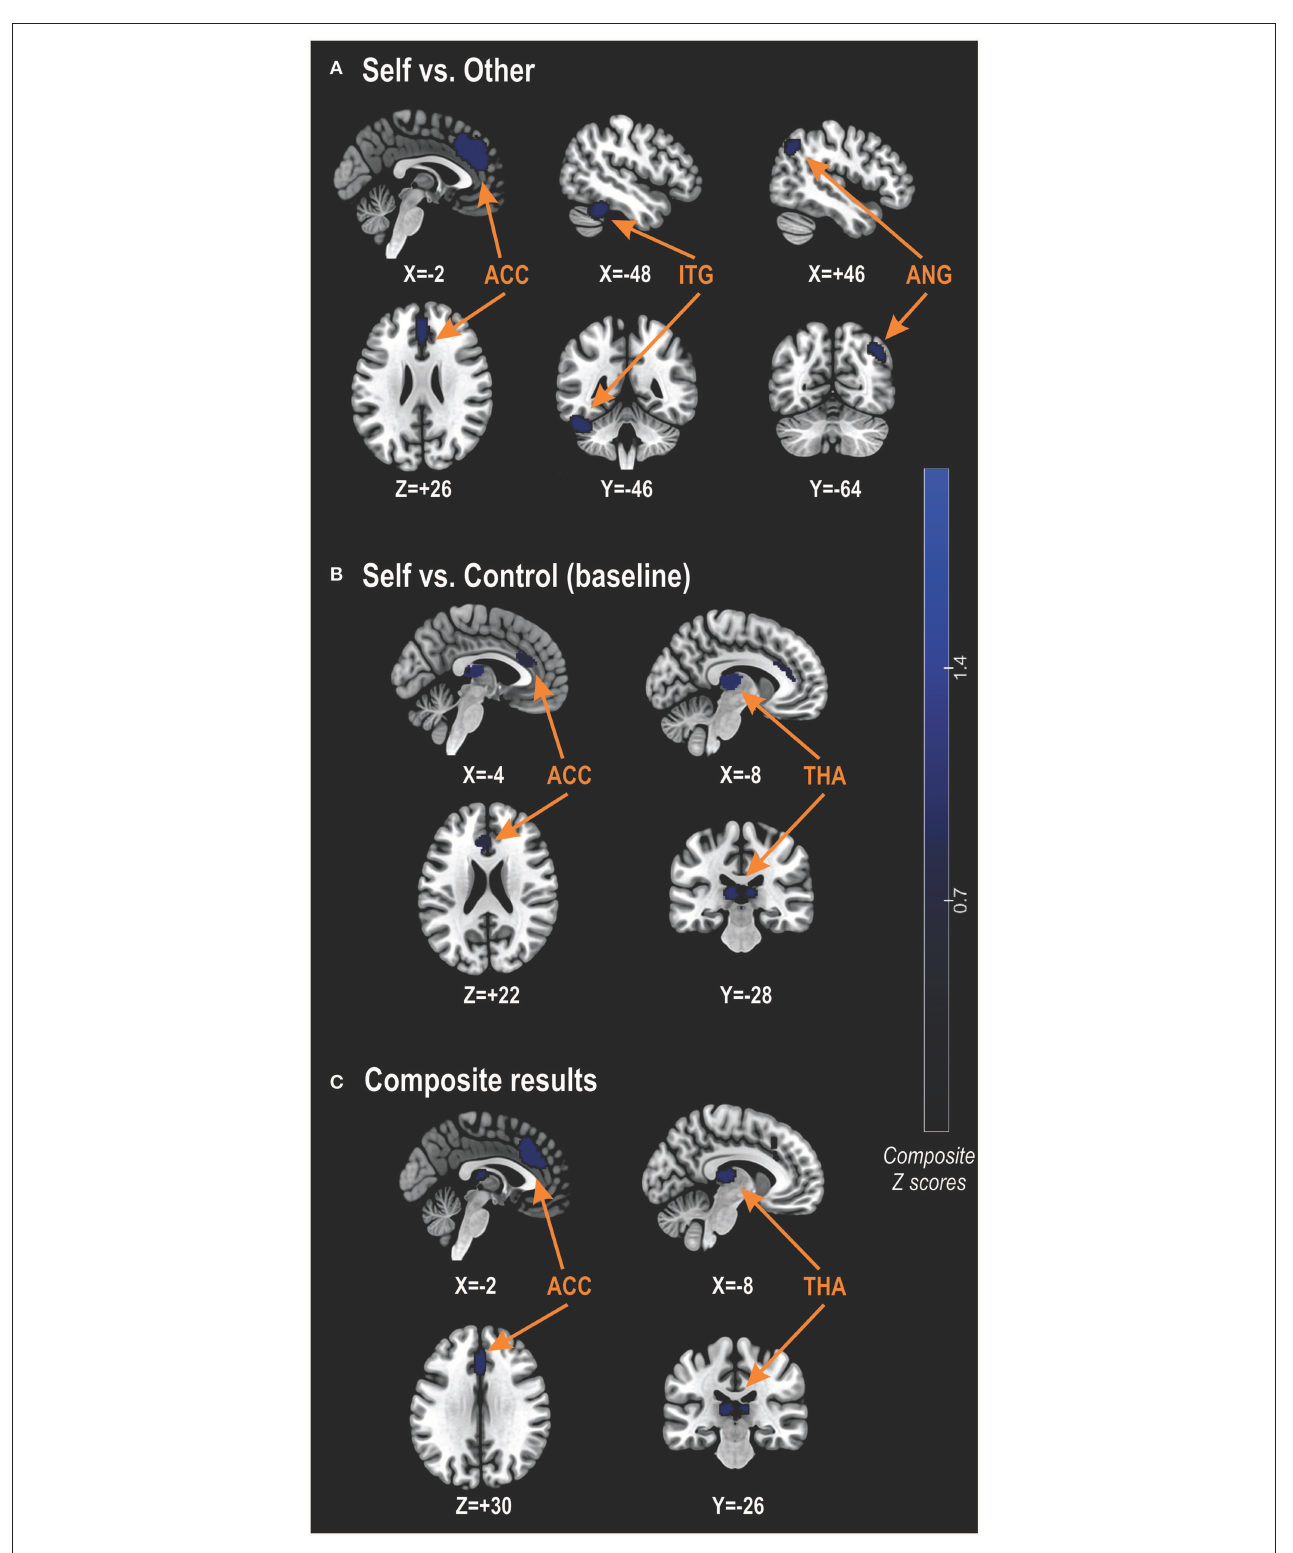
FIGURE 2 | Between-group differences in self-related brain activations. (A) Results for the between-group differences in brain activations using the Self vs. Other contrast. (B) Results using the Self vs. Control (baseline) contrast. (C) Results for the composite analysis, combining every studies including in the meta-analysis. ACC, anterior cingulate cortex; ANG, angular gyrus; ITG, inferior temporal gyrus; THA, thalamus.